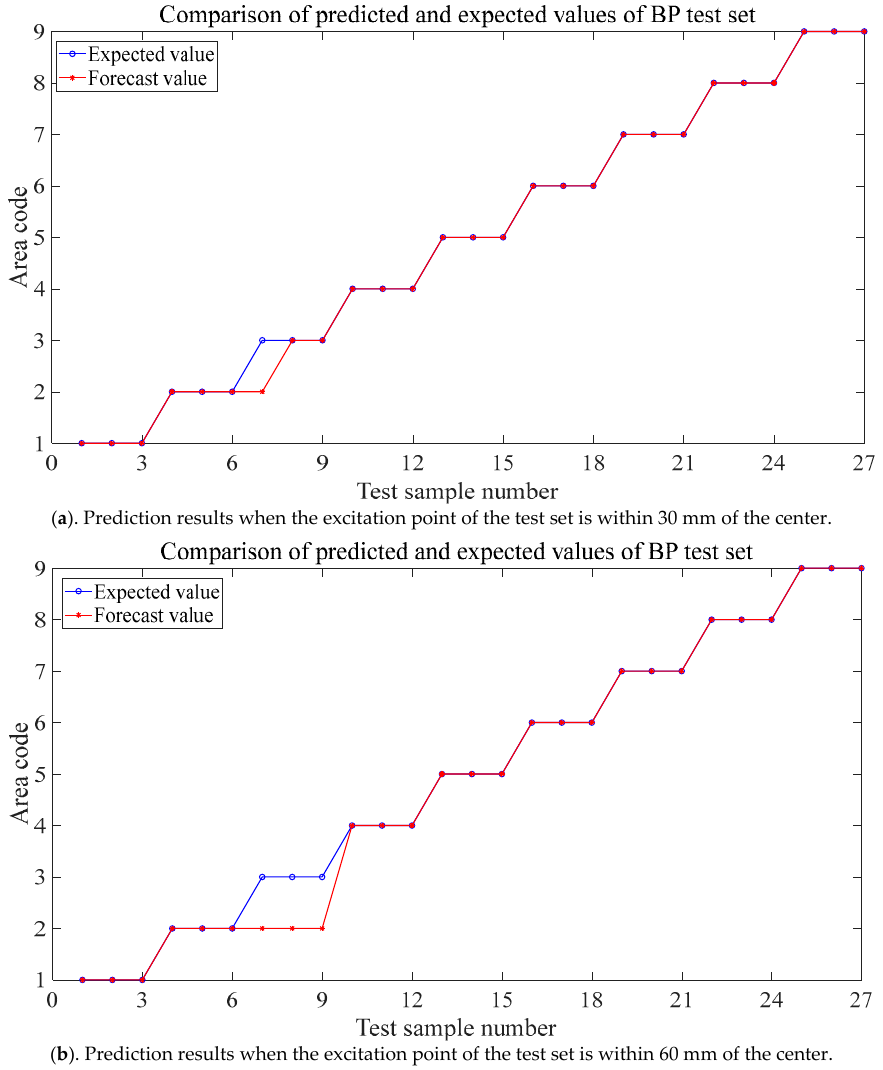
Figure 23. Prediction results in a laboratory